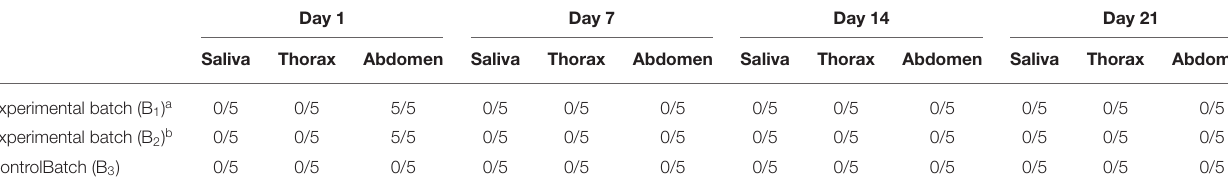
TABLE 1 | Number of samples positive for HEV RNA at each